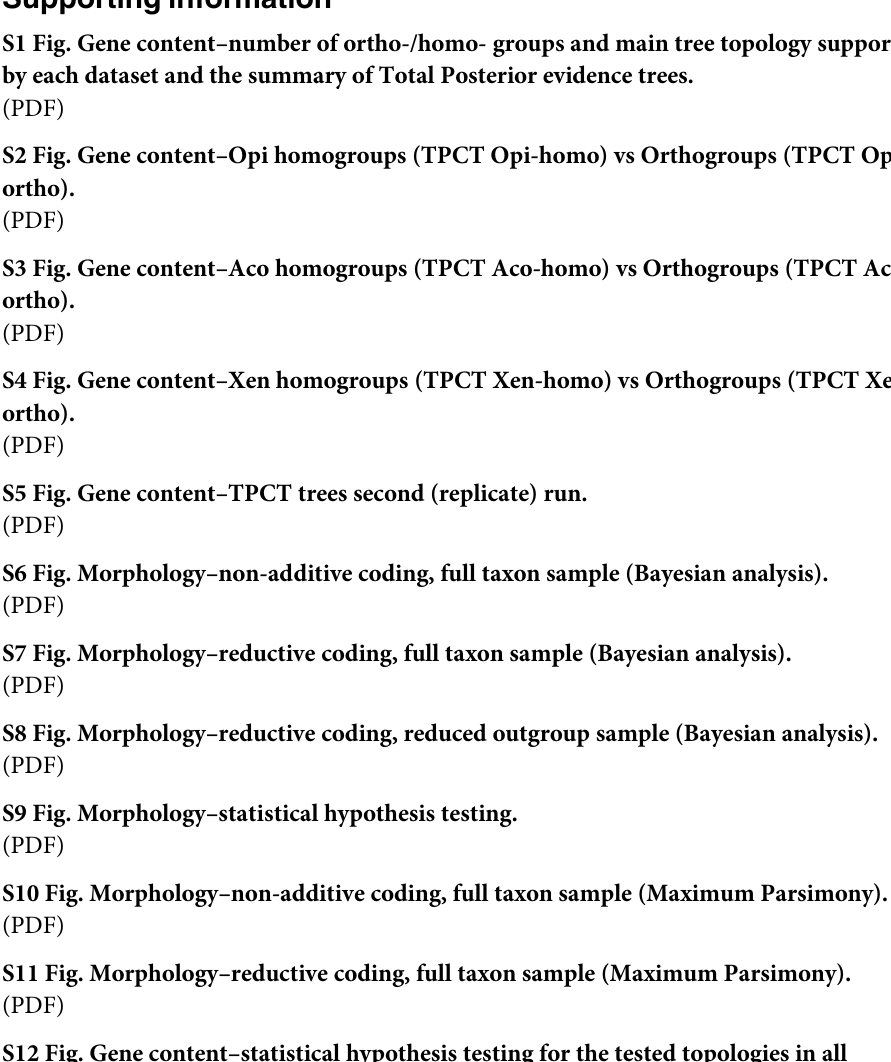
orthogroups based datasets. S13 Fig. Gene content–statistical hypothesis testing for the tested topologies in all homo- groups based datasets. S14 Fig. “Total evidence” Phylogeny of the combined gene content and morphological datasets. S1 Table. Species summary. S2 Table. Run 1—convergence